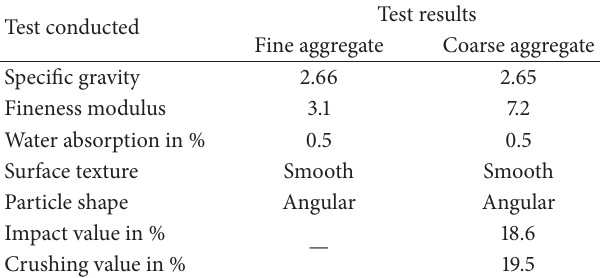
Table 2: Properties of aggregates.